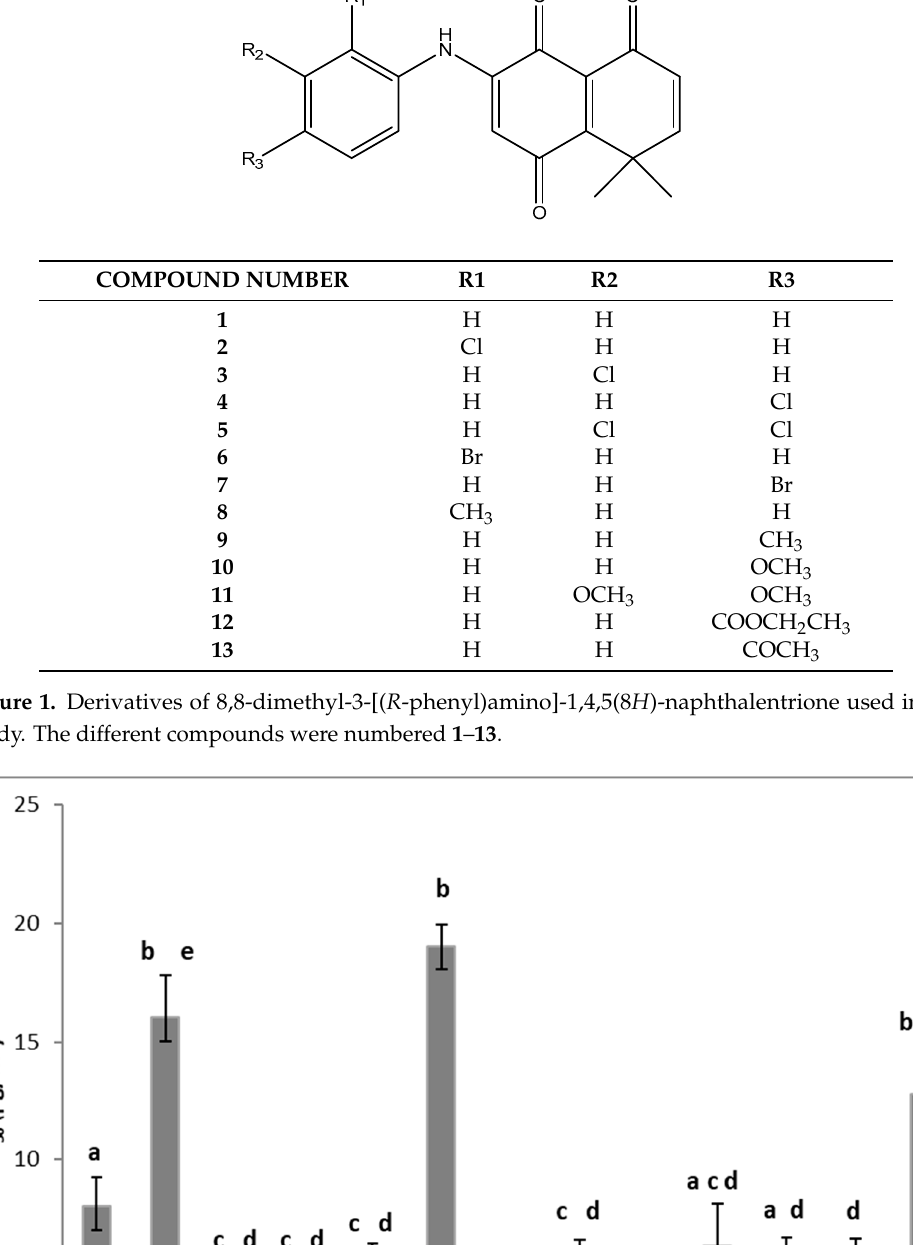
Figure 1. Derivatives of 8,8-dimethyl-3-[( R -phenyl)amino]-1,4,5(8 H )-naphthalentrione used in this study. The different compounds were numbered 1 – 13 .